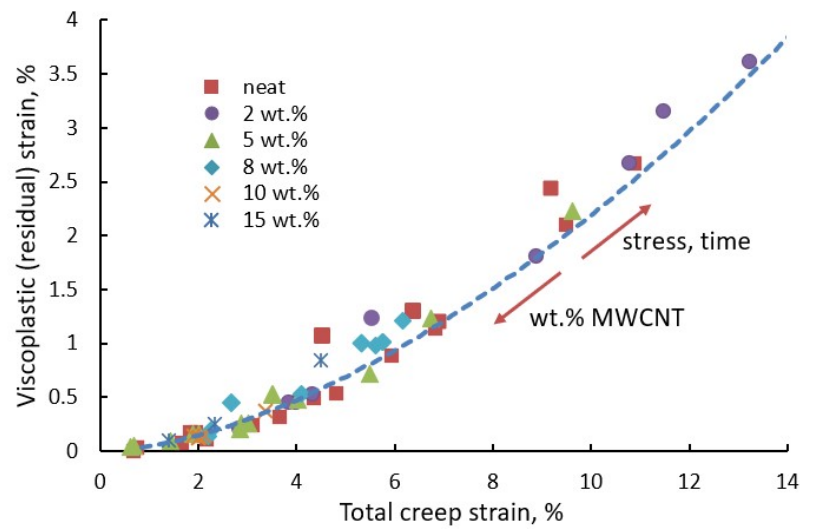
Figure 10. Residual recovery strain vs. total creep strain for polypropylene filled with different contents of MWCNT. Data obtained in creep-recovery tests under various loads and creep times; one point corresponds to one creep-recovery test. Data reproduced from